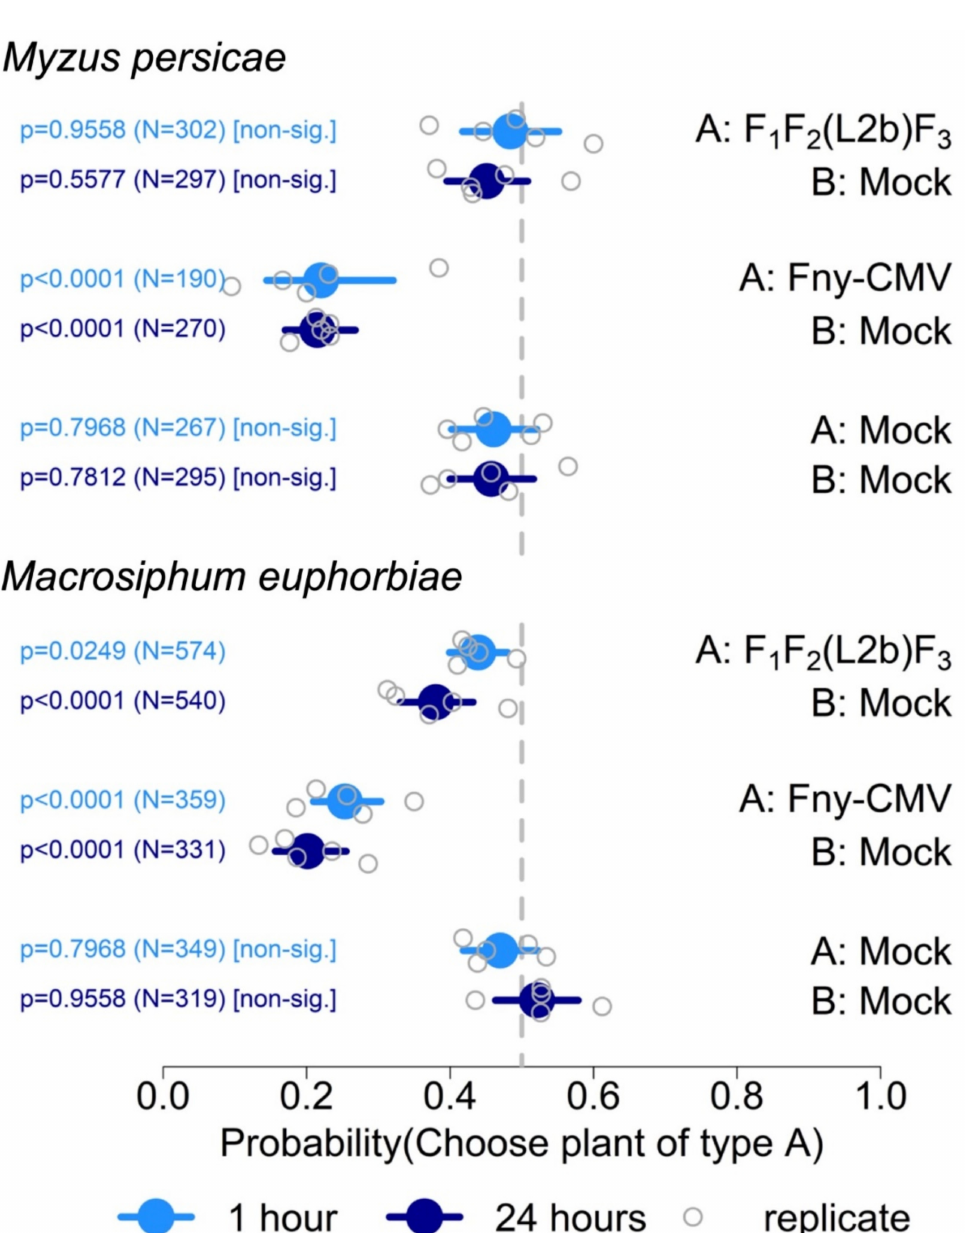
Figure 6. Summary of free-choice aphid preference assays using mock-inoculated tomato plants or plants infected with wild-type Fny-CMV or a recombinant CMV expressing the 2b protein of LS-CMV at 21 days post-inoculation. The x -axis shows the range of the 95% credible interval of the probability of settlement of aphids ( Myzus persicae or Macrosiphum euphorbiae ) on infected plants at 1 and 24 h after aphid release, with values for each independent experiment (replicate). The total number of aphids (N) investigated for each comparison is indicated and statistical significance or non-significance determined using binomial tests. The vertical grey dotted lines indicate a probability of 0.5 of settlement on infected versus mock-inoculated plants, i.e., no settlement